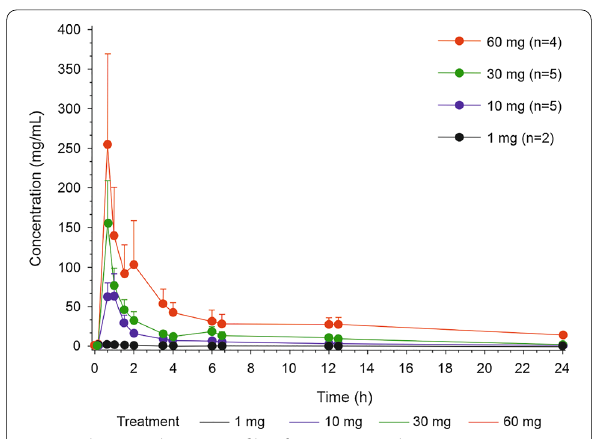
Fig. 2 Pharmacokinetic profile of ORM-12741 showing mean ( standard error of mean) plasma concentrations following oral ± administration of four single doses to fasted healthy male